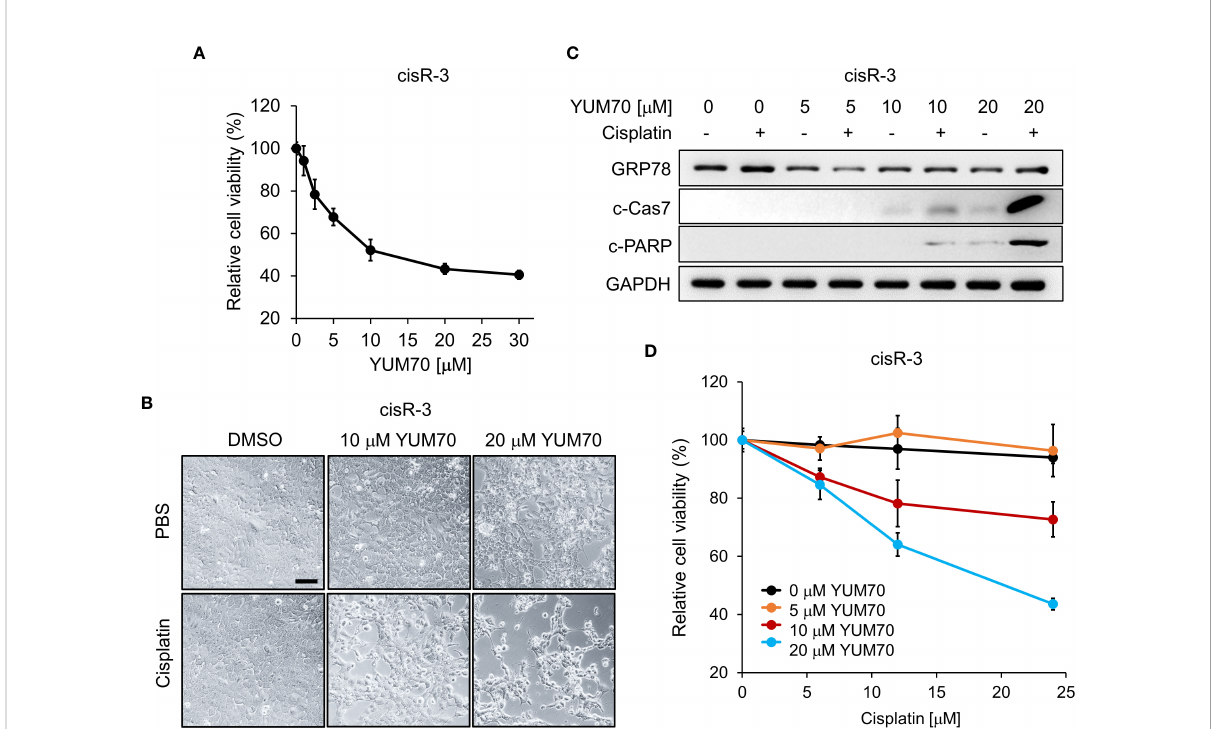
FIGURE 6 YUM70 reduces cell viability and restores cisplatin sensitivity in cisplatin-resistant SCC15. (A) Cisplatin-resistant SCC15 cells (the cisR-3 line) were treated with increasing doses of YUM70 for 48 hr. Cell viability was determined by WST-1 assay. DMSO was used as vehicle control. (B) Representative images of cisR-3 cells treated with the indicated dosages of YUM70 alone or in combination with 12 m M cisplatin for 48 hr. Scale bar = 100 m m. (C) Western blot of lysates of cisR-3 cells treated with the indicated dosages of YUM70 for 48 hr, alone or in combination with 12 m M cisplatin. The protein levels of cleaved Caspase 7 (c-Cas7) and cleaved-PARP (c-PARP) were measured, with GAPDH serving as loading control. (D) Cell viability of cisR-3 cells treated with the indicated dosages of YUM70, alone or in combination with the indicated dosages of cisplatin for 48 hr was measured by WST-1 assay. Data are presented as means ± S.D.